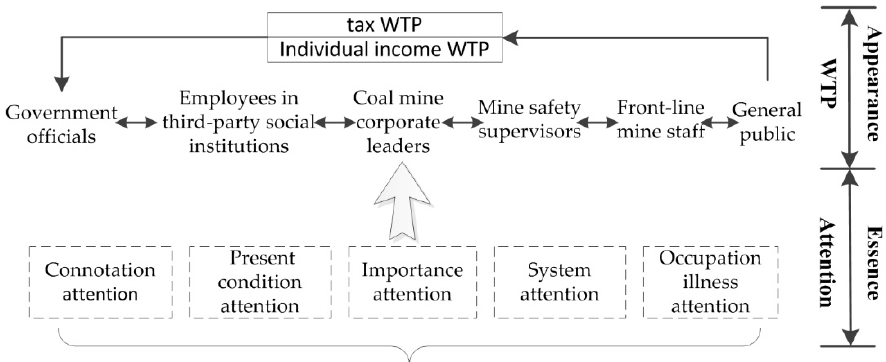
Figure 1. The roadmap of the relationship between the attention to occupational safety and health and willingness to pay (WTP) based on different subject identities.